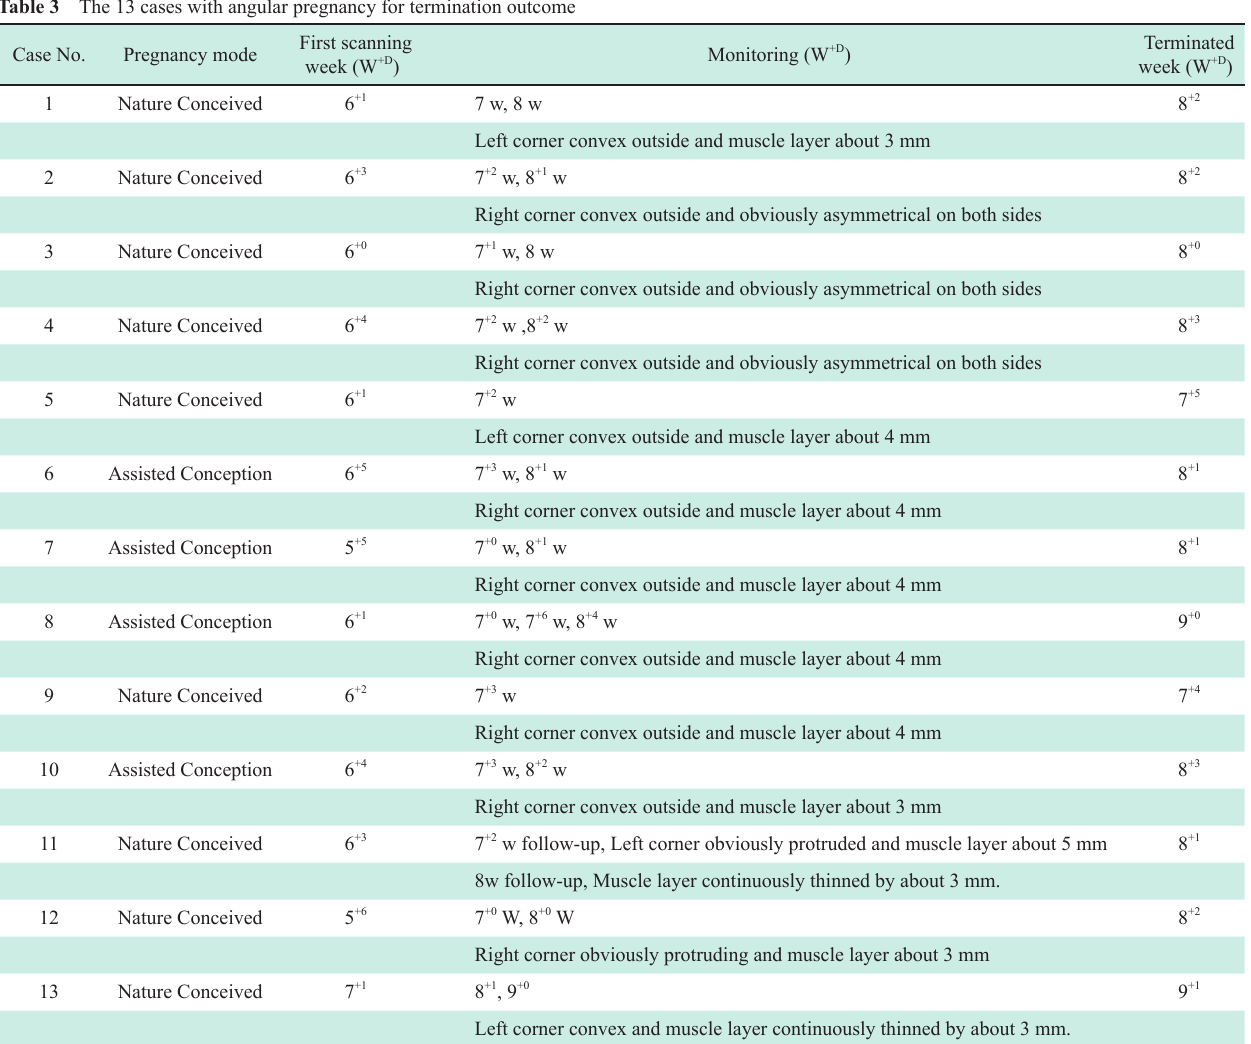
Table 3 The 13 cases with angular pregnancy for termination outcome Case